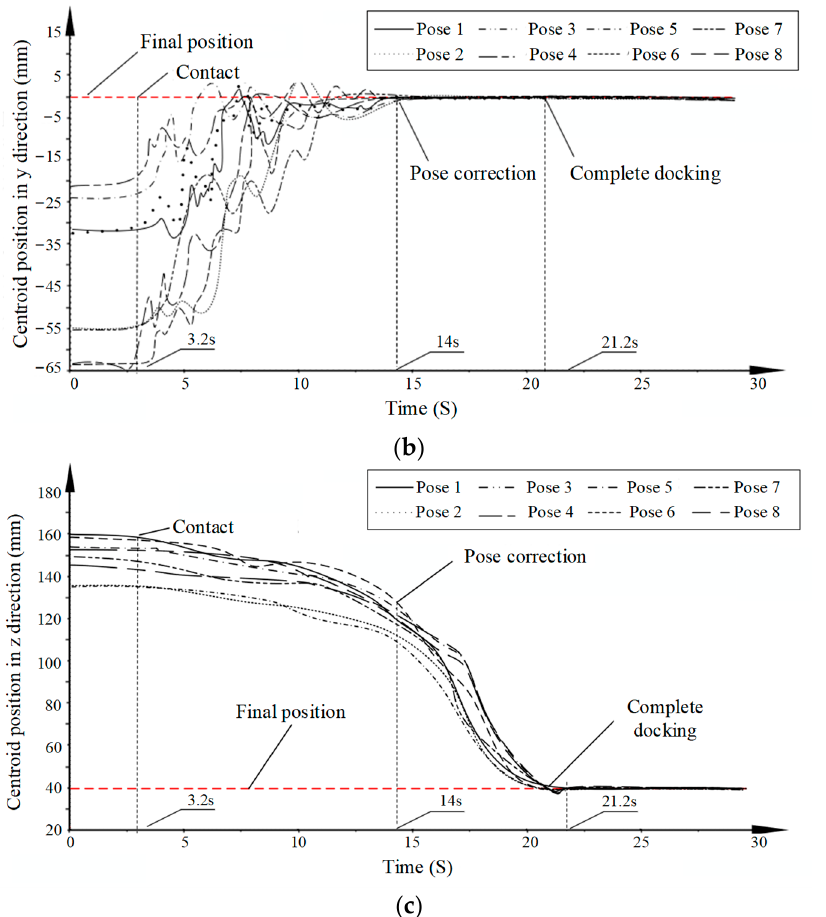
Figure 18. Centroid position of the passive part of the docking mechanism: ( a ) In x direction; ( b ) In y direction; ( c ) In z direction.